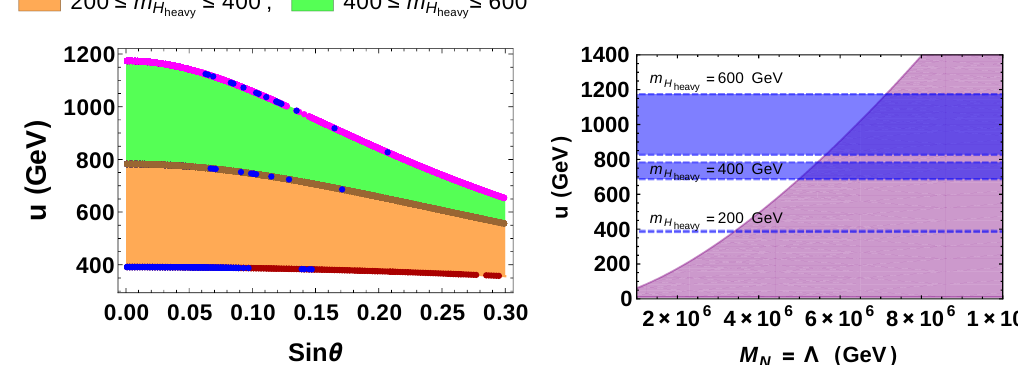
Figure 14 . Left panel: u (= M (cid:31) =y ) vs sin (cid:18) plot for (cid:21) 1 = (cid:21) 2 = (cid:21) for 200 (cid:20) m H (cid:20) 400 GeV heavy (orange shaded region) and 400 (cid:20) m H (cid:20) 600 GeV (green shaded region) respectively. Here the heavy magenta, brown and deep red dots represent allowed points obtained (from (cid:12)gure 8) relic density only, for m H = 100, 80 and 60 GeV. Blue dots on each line are actual allowed points which light also satisfy direct search limit. Right panel: u (= M (cid:31) =y ) as a function of (cid:3) (or M N ) considering M N = (cid:3) in eq. (5.1) and (5.2). Purple shaded region represents m (cid:23) (cid:20) 0 : 23 eV with M N = (cid:3) and the horizontal blue patch represents the allowed region of u (= M (cid:31) =y ) obtained the left panel for the speci(cid:12)c heavy Higgs masses. This imposes a constraint on the lower limit of the cut-o(cid:11) scale (cid:3) (and RH neutrino mass M N